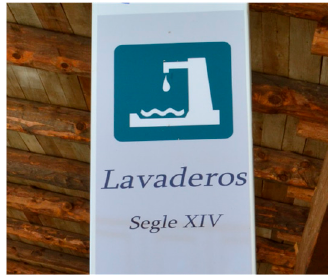
Figure 41. Benasal: Language contact on a laundry sign .